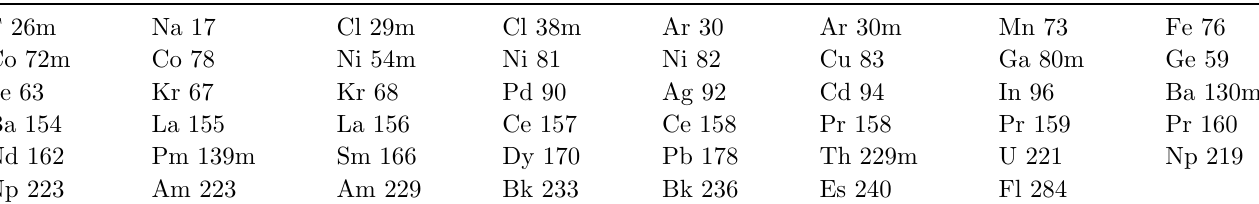
isotopicabundanceandanexperimentallyobservedhalf-life.